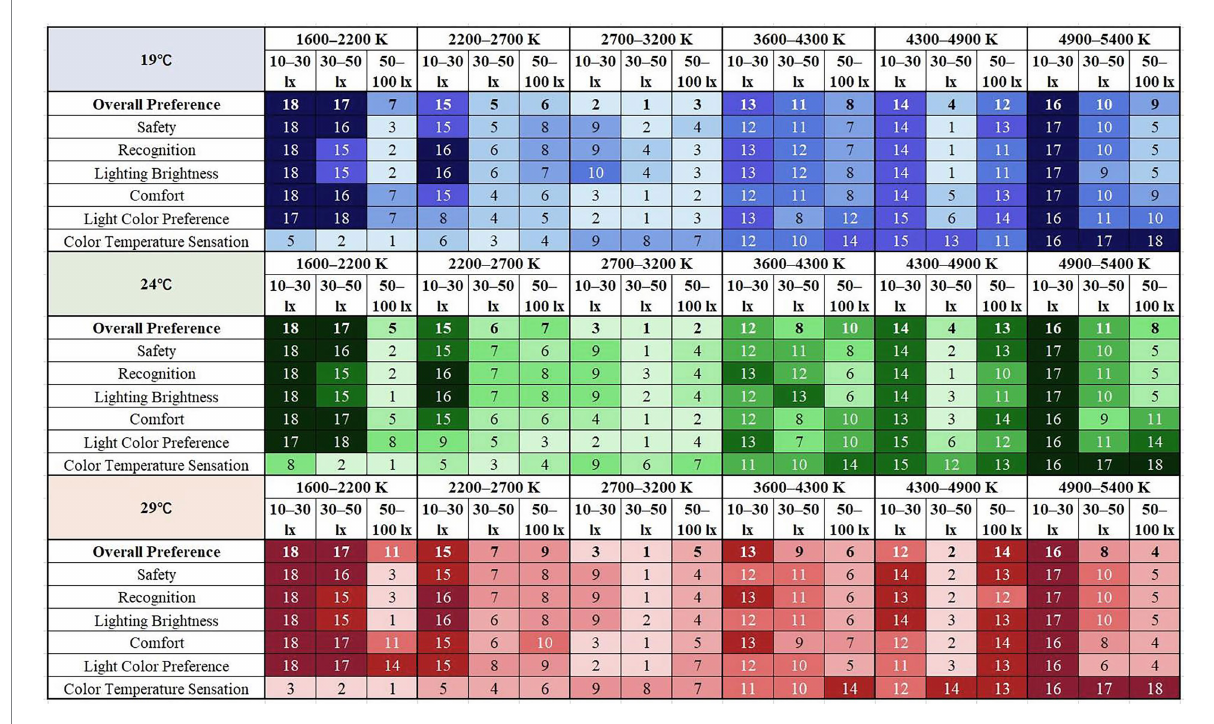
FIGURE 8 Evaluation rankings of different street lighting under three experimental